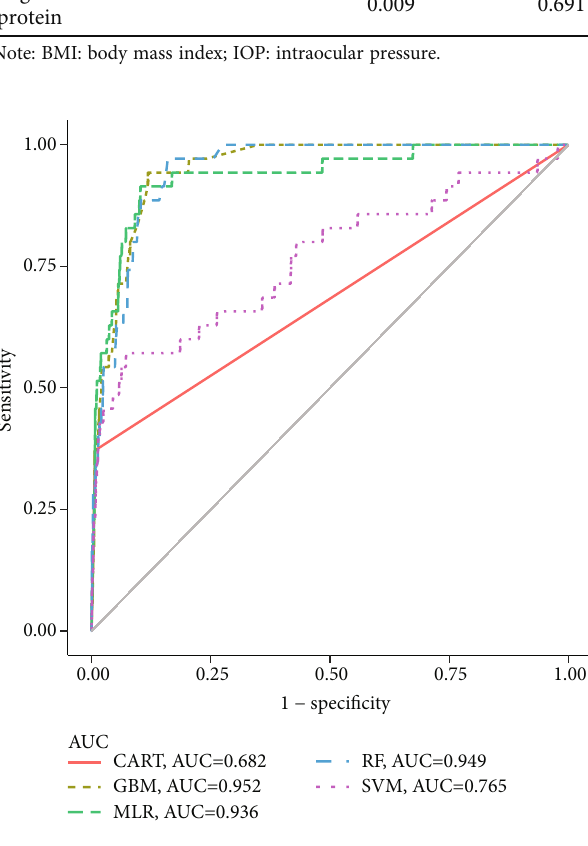
Figure 2: ROC curve of prediction models.